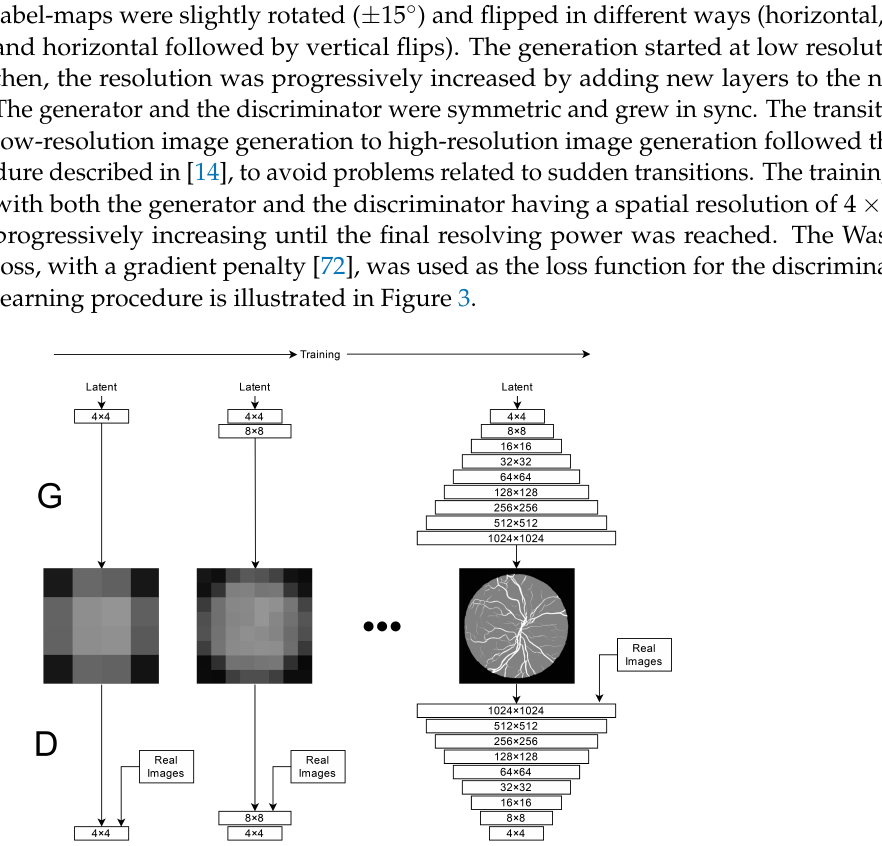
Figure 3. Training scheme for the generation of the semantic label-maps. The resolutions of the generator (G) and the discriminator (D) were progressively increased until the final resolving power was